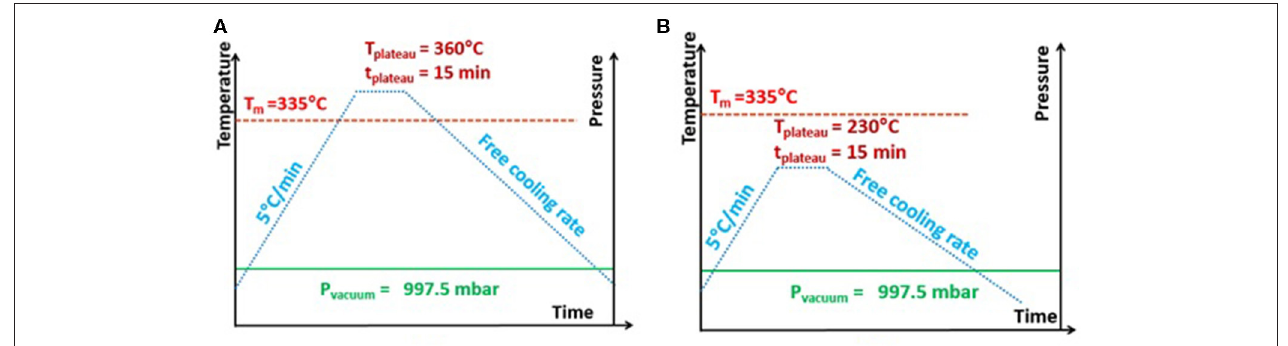
FIGURE 3 | Manufacturing cycles. (A) First cycle. (B) Third